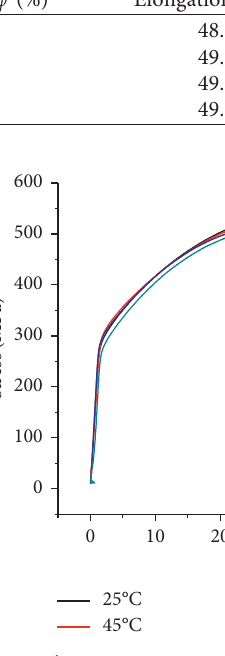
Figure 6: The stress-strain curve of 316L stainless steel at different temperatures.